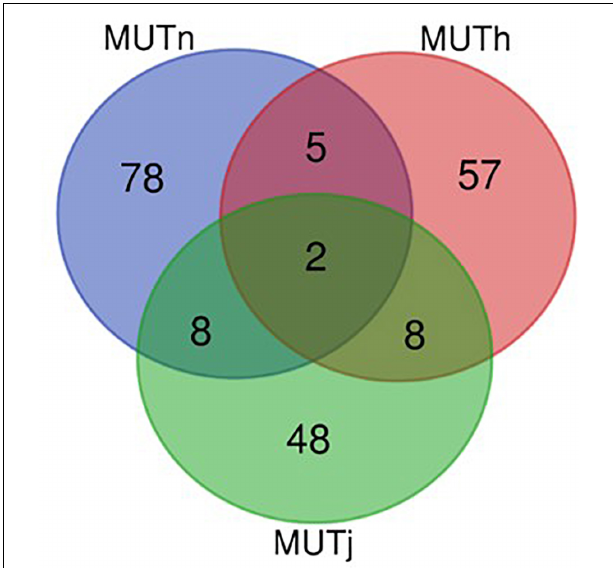
FIGURE 8 | Venn diagram of unique and shared genes within candidate selected regions between Muturu and other taurine following Rsb analysis.